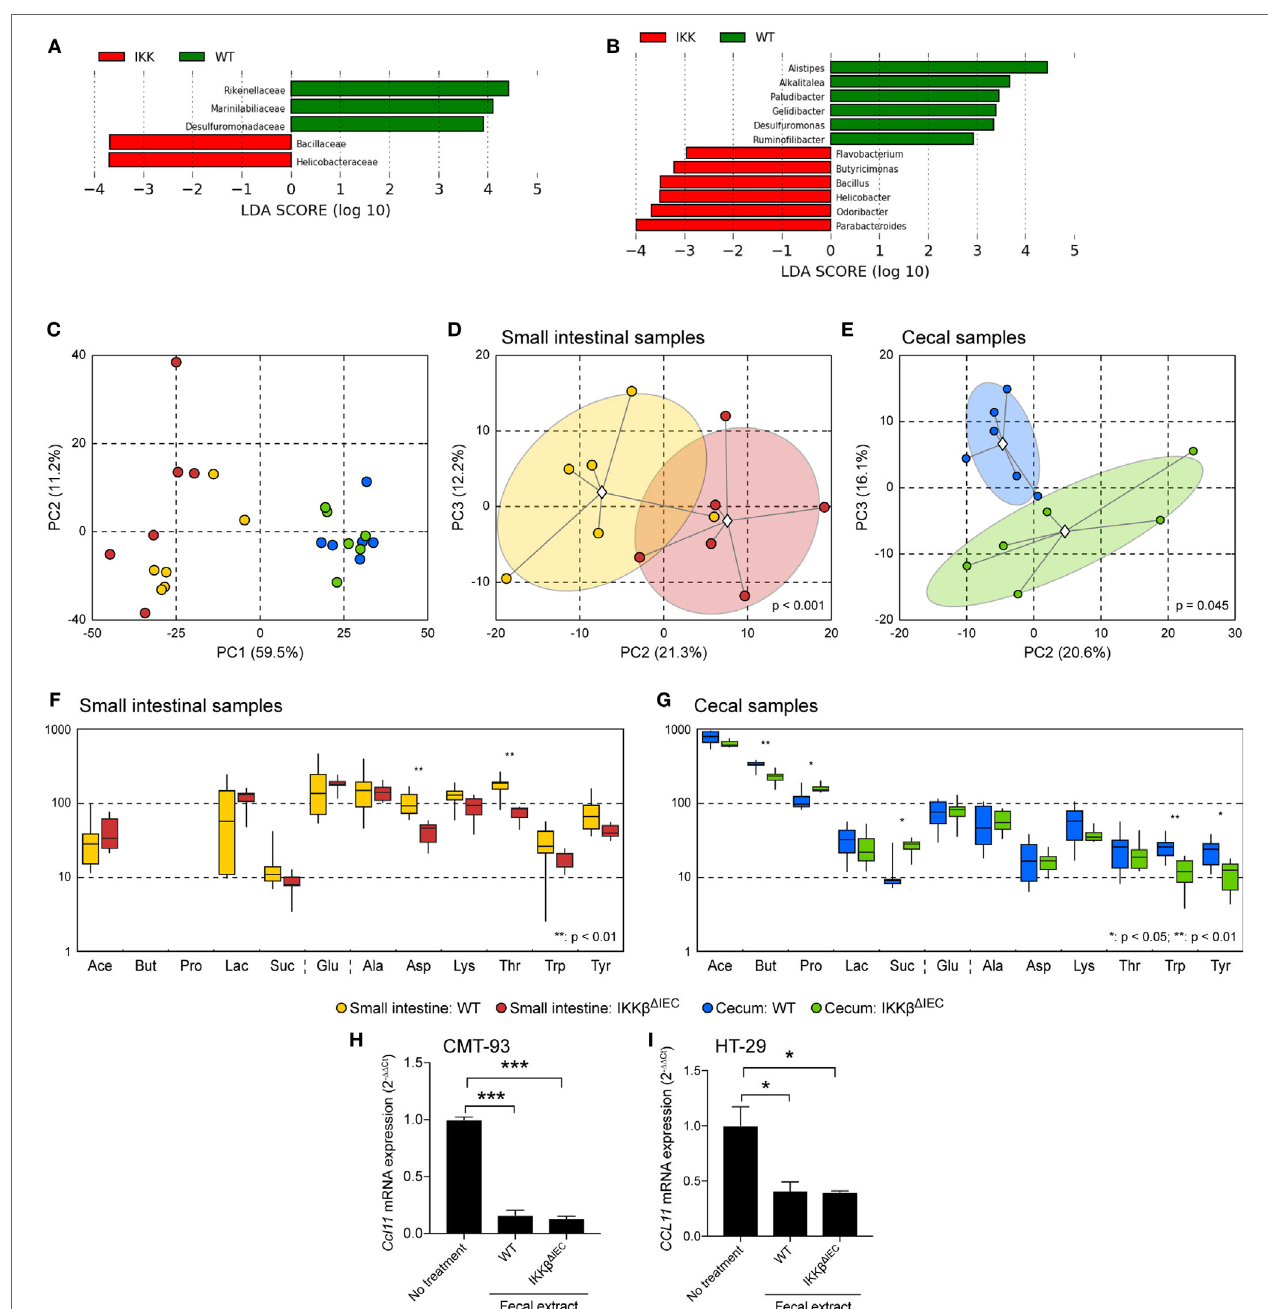
FigUre 4 | Commensal bacteria and metabolite profiles are altered in the gut of naïve IKK β Δ IEC mice. (a,B) Linear discriminant analysis (LDA) of the abundances of commensal gut bacteria. Freshly emitted fecal pellet were normalized by weight and microbial composition determined by 16S RNA analysis. (a) LDA scores at the family level. (B) LDA scores at the genus level. (c–g) Metabolite profiling. (c–e) Principal component analyses (PCA) of metabolite profiles. Different groups are denoted by colors as shown in the legend. Group clouds represent areas of three SEs around the group centroid (diamond). Percent of total variance captured by each principal component is shown in parentheses. P values indicate the statistical significance of group separation in the first three components of the PCA space as assessed by permutation analysis of Davies-Bouldin index. (c) Small and large intestines; (D) small intestine; (e) large intestine. (F) Distribution of concentrations of major metabolites in the small intestine. (g) Distribution of concentrations of major metabolites in the large intestine. Boxplot whiskers depict minimum and maximum values for each group. P values were calculated using two-tailed T -test, * p < 0.05; ** p < 0.01 (five mice/group). Abbreviations: Ace, acetic acid; But, butyric acid; Pro, propionic acid; Lac, lactic acid; Suc, succinic acid; Glu, glucose; Ala, alanine; Asp, aspartic acid; Lys, lysine; Thr, threonine; Trp, tryptophan; Tyr, tyrosine. Note that there were no discernable nuclear magnetic resonance peaks for butyric and propionic acids in any small intestinal samples. (h,i) CCL11 mRNA expression of in murine CMT-93 (h) and human HT-29 intestinal epithelial cells (i) . Cells were cultured for 12 h in the presence of bacterial-free fecal extracts from wild-type and IKK β Δ IEC mice. * p < 0.05; ** p < 0.01; *** p < 0.001 compared to no treatment